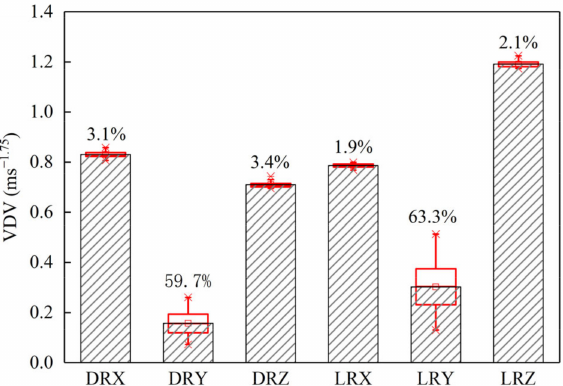
Figure 5. Variation of vibration dose value (VDV) at seat rails due to changes of bushing stiffness and damping.